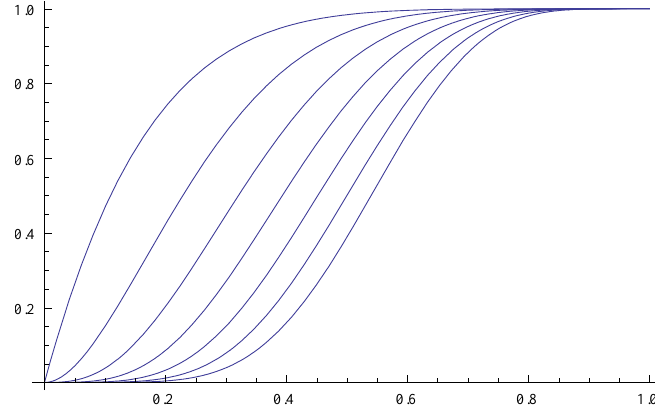
Figure 4. The reliability polynomial of the linear < n ,6,2> for n = 6,7,...,12.